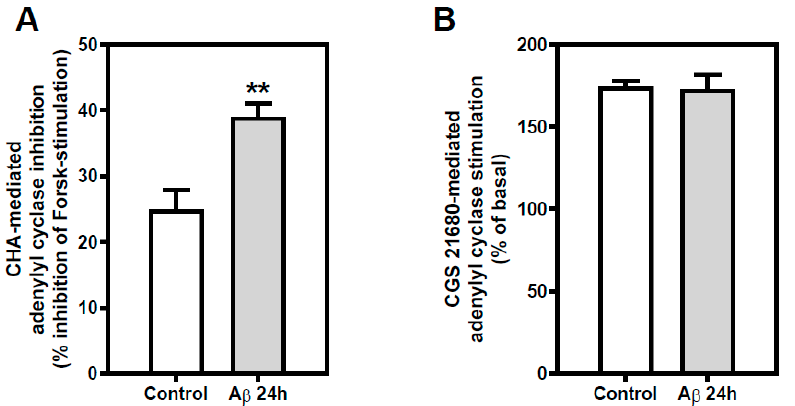
Figure 6. Effect of A β 25-35 exposure AR-mediated adenylyl cyclase pathway in cortical neurons. ( A ) Inhibitory effect of 1 µ M CHA, selective A 1 R agonist, on forskolin-stimulated cyclic AMP accumulation in intact cortical neurons was measured. A β 25-35 exposure in cortical neurons increased A 1 R-mediated AC inhibition. ( B ) Stimulatory effect of 1 µM CGS 21680, selective A 2A R agonist, was measured in intact neurons exposed to 25 µM A β 25-35 for 24 h or maintained under control conditions. Histograms represent mean ± SEM values obtained from at least three independent experiments performed in duplicate using different preparations. * p < 0.05 ** p < 0.01 significantly different from control value using one-way ANOVA and Bonferroni’s post hoc test.